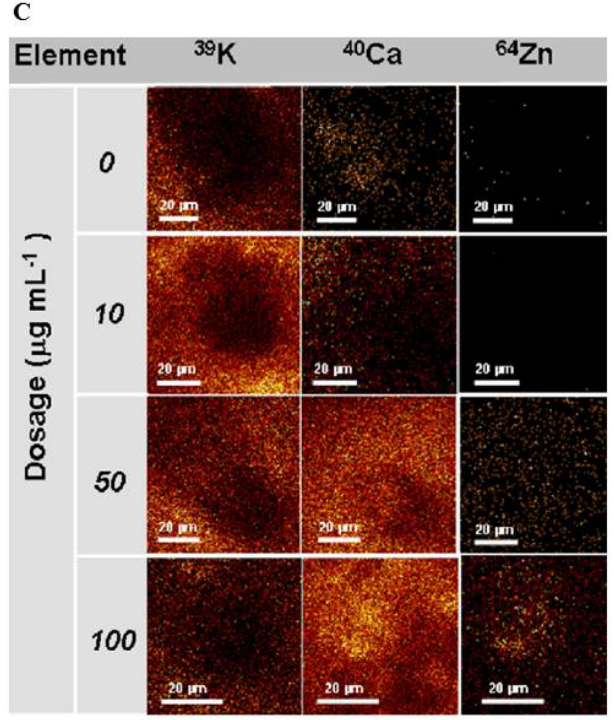
Figure 11. ( A ) Schematic illustration of integrating CLSM and Tof-SIMS image analyses for cytotoxicity study of ZnO NPs in HaCaT cells. ( B ) The confocal images of HaCaT cells treated with different ZnO NPs concentration ( a ) 0, ( b ) 10, ( c ) 50, and ( d ) 100 μ g/mL; 68 ZnO NPs ( e ) 10, ( f ) 50, and ( g ) 100; ( h , i ) enlarged images of individual cells treated with 50 and 100 μ g/mL ZnO NPs. Green fluorescence and red color, respectively, represent the ZnO ( 68 ZnO) NPs and nuclei of HaCaT cells (highlighted by arrow mark in ( f ): 68 ZnO NPs). ( C ) The TOF-SIMS ion images of 39 K + , 40 Ca + , and 64 Zn + of HaCaT cells treated with 0, 10, 50, and 100 μ g/mL ZnO NPs. Scale bar is 20 μ m [144]. Reprinted/adapted with permission from Ref. [144]. Copy right 2014, copyright Elsevier.